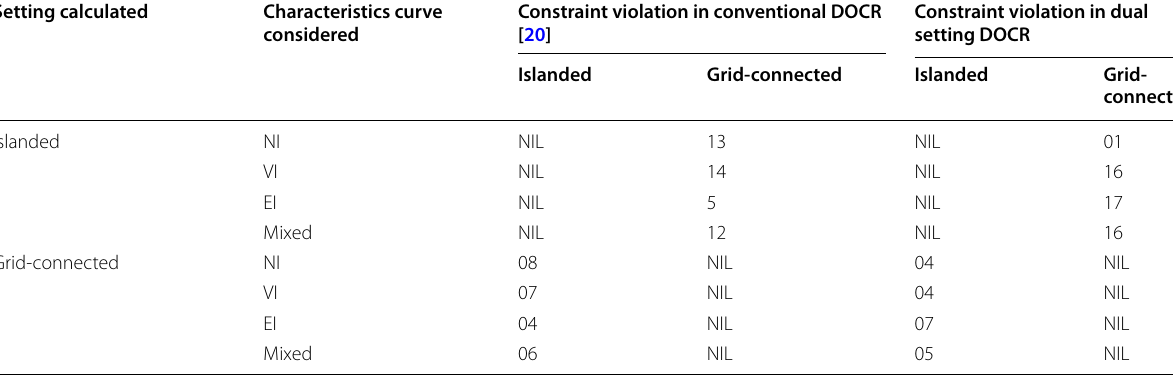
Table 7 Coordination constraint violation summary of the 7-bus microgrid system using GA Setting calculated Characteristics curve